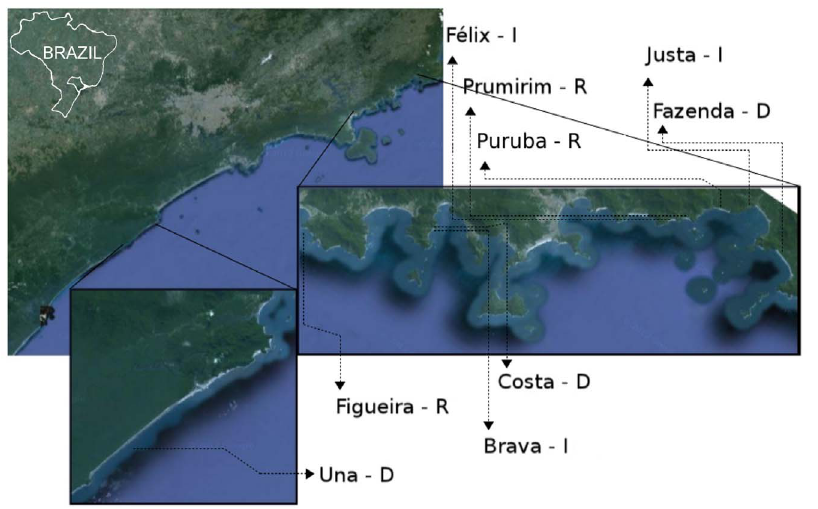
Figure 1. Study area. Satellite image of southeastern Brazil and detail of the study area. The nine beaches are between 24 u 31 9 S, 47 u 10 9 W and 23 u 22 9 S, 44 u W50 9 . Each is named and followed by a letter indicating its morphodynamics: D – dissipative, I – intermediate and R – reflexive. Map data: Google, Cnes/Spot Image, DigitalGlobe, Landsat, TerraMetrics.